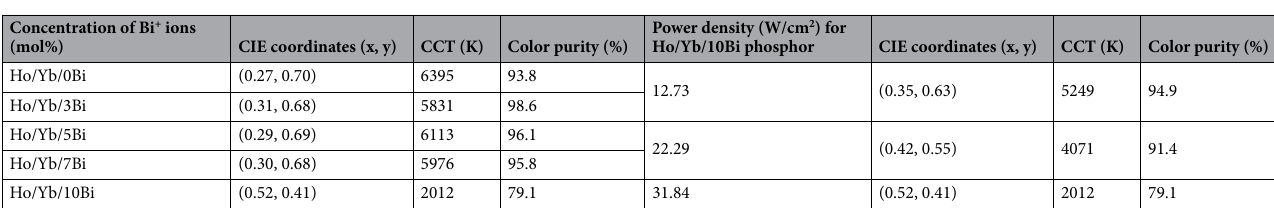
Table 2. Variations of CIE coordinates, CCT values and color purity with various concentrations of Bi 3+ ion in the Ho 3+ /Yb 3+ co-doped materials and at various power densities of 980 nm excitations for the Ho 3+ / Yb 3+ /10Bi 3+ co-doped